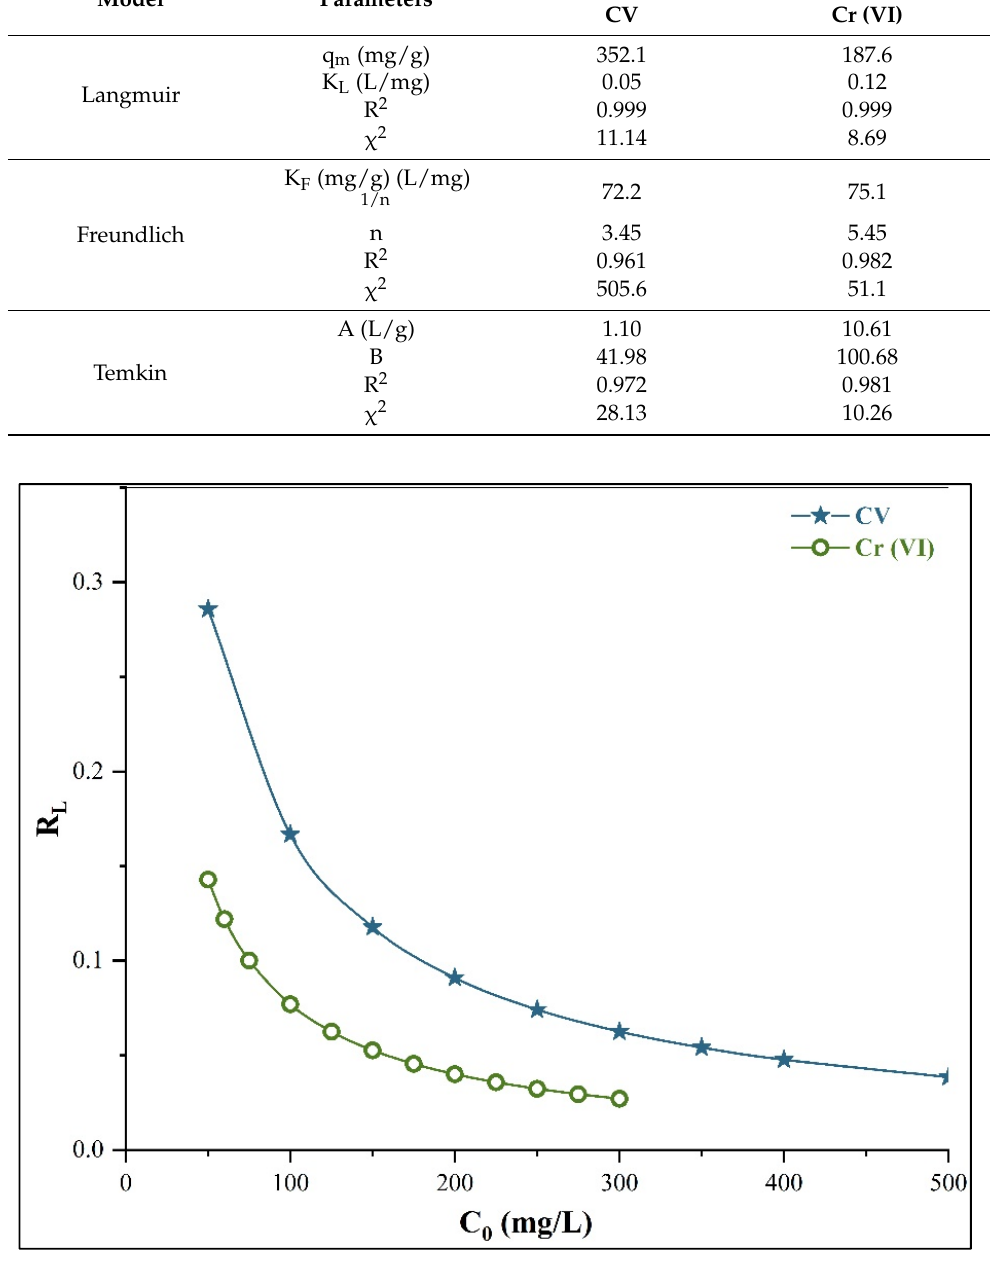
Figure 14. Separation factor for the adsorption of Cr (VI) and CV on